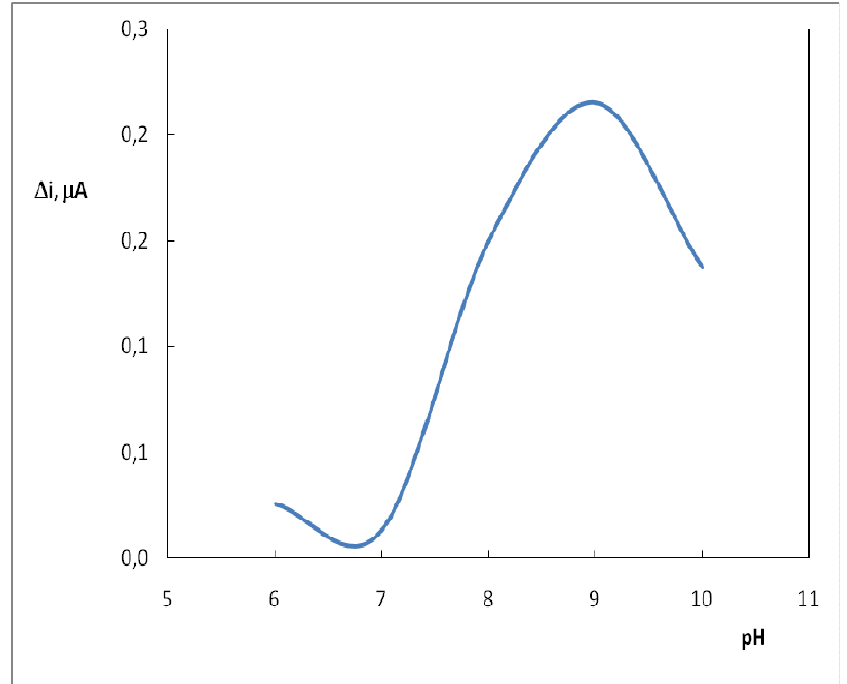
Figure 2. The effect of solution pH on the response to 4.0×10 -5 M uric acid in 0.05 M borate buffer solution of 25 o C. The operating potential is 0.4 V vs.